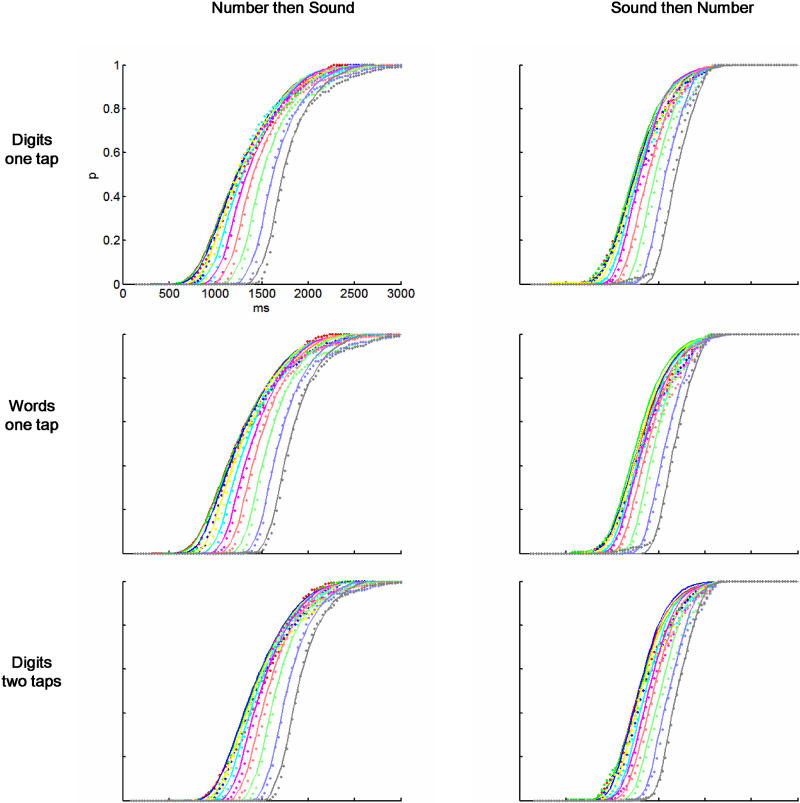
Predicting the Distribution of RTs to the Second Task from the PRP ModelLeft: Cumulative plots of RTs to the number task when it is presented second (dots) and the predicted distribution based on the PRP model (solid lines). Each curve (coded in different colours) represents one of the ten possible values of Δ.Right: Same data for RTs to the tone task when it is presented second (dots) and the predicted distribution from the PRP model (solid lines). Each row corresponds to a different task: Digits 1 Tap (first row), Digits 2 Taps (second row), and Words 1 Tap (third row). Each panel was fit with three parameters: M1, P2, and a fixed delay.